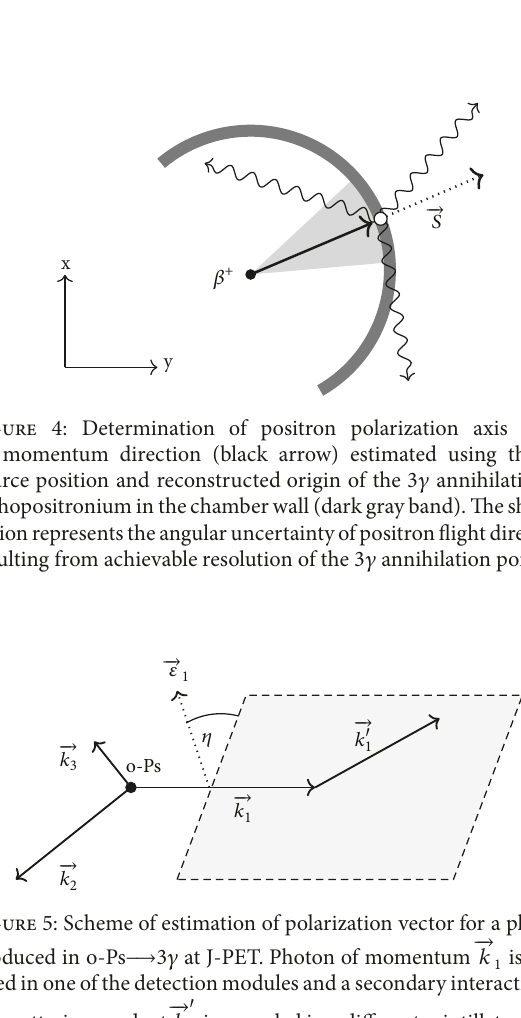
󳨀→ 𝑘 1 is scat- 󳨀→ 耠 𝑘 1 is recorded in a different scintillator strip. 󳨀→ 𝜀 1 and 󳨀→ 󳨀→ 耠 𝑘 𝑘 90 ∘ 1 and 1 amounts to